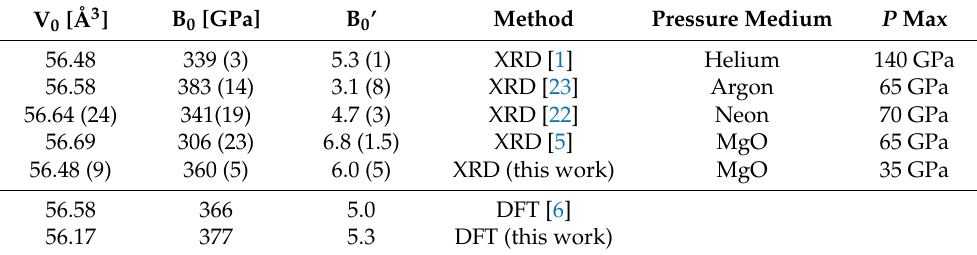
Table 1. EoS parameters (at 300 K) determined from present and previous studies whose references are indicated in the center column. In the upper part, we show results from experiments indicating the pressure medium and the maximum P reached during the experiment. In the lower part, we show results from